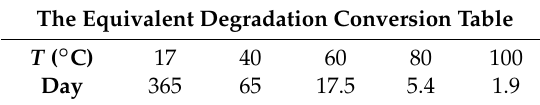
Table 7. Equivalent degradation conversion results.